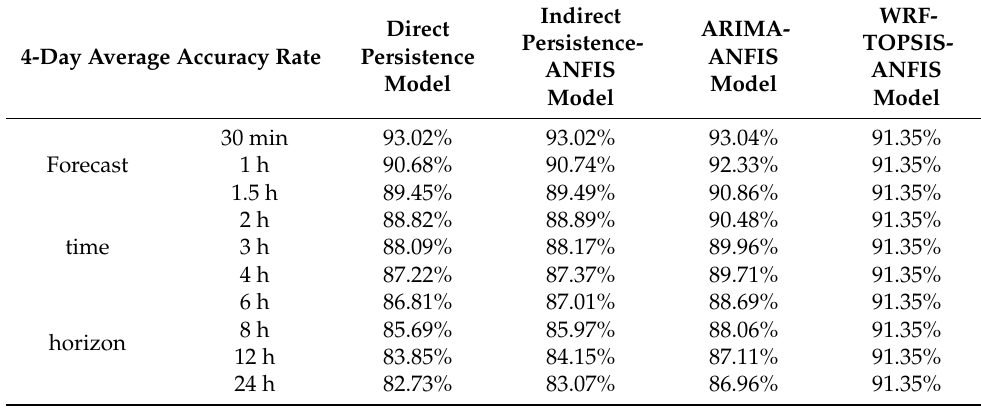
Table 17. Four-day average accuracy rate for the wind power forecasting using the direct persistence, indirect persistence-ANFIS, ARIMA-ANFIS, and WRF-TOPSIS-ANFIS models applied to the 4-day test dataset.